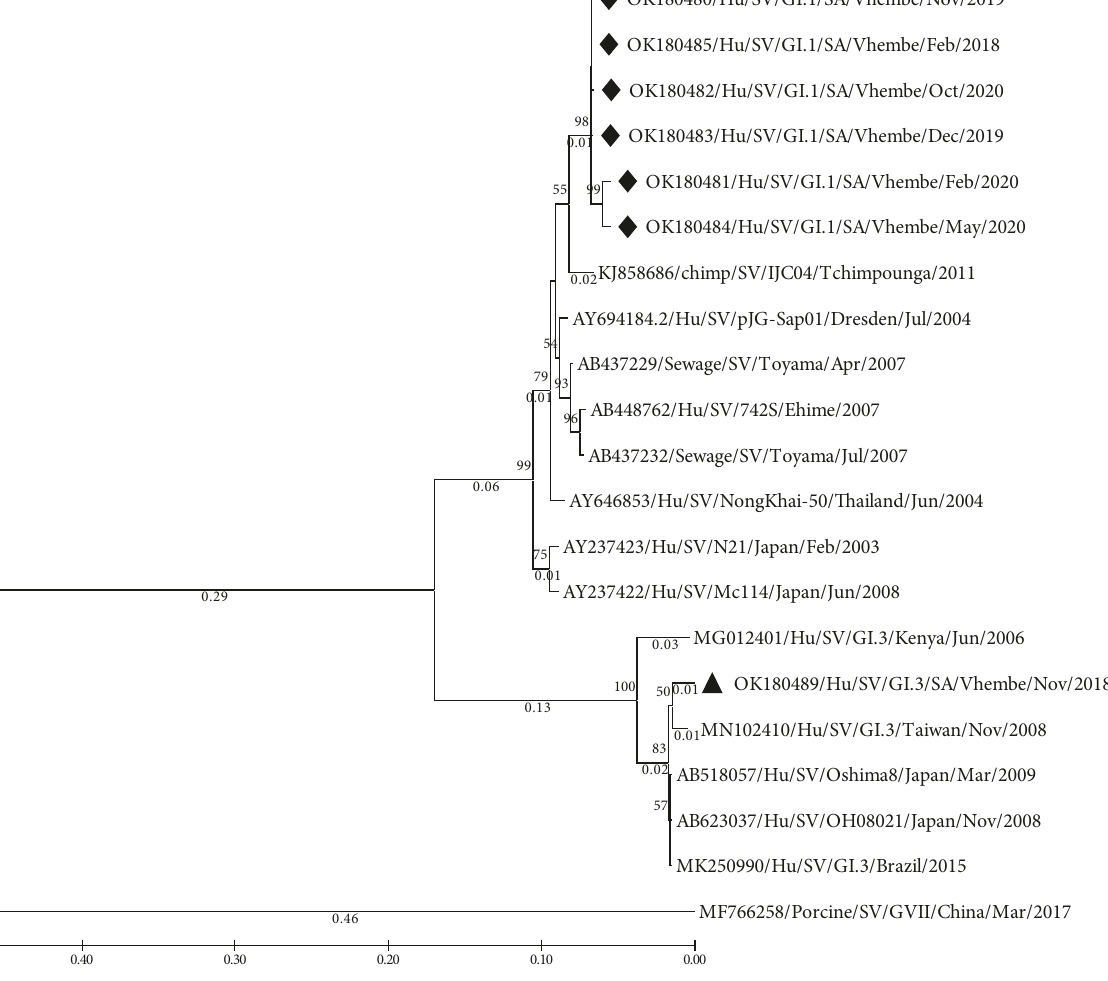
Figure 2: Phylogenetic analysis of the partial polyprotein of human SV-GI detected in Vhembe district (South Africa) and reference strains selected from the GenBank database. The percentage of replicate trees in which the associated taxa clustered together in the bootstrap test (1000 replicates) are shown next to the branches. A bar scale representing a genetic distance scale. The phylogenetic tree was deduced by the maximum likelihood method and the Kimura 2-parameter model using MEGA 11 [20, 21], based on a 709-nucleotide sequence fragment of the polyprotein (a VP1 segment) showing relationships of SV strains. The porcine SV (MF766258) was selected as an outgroup